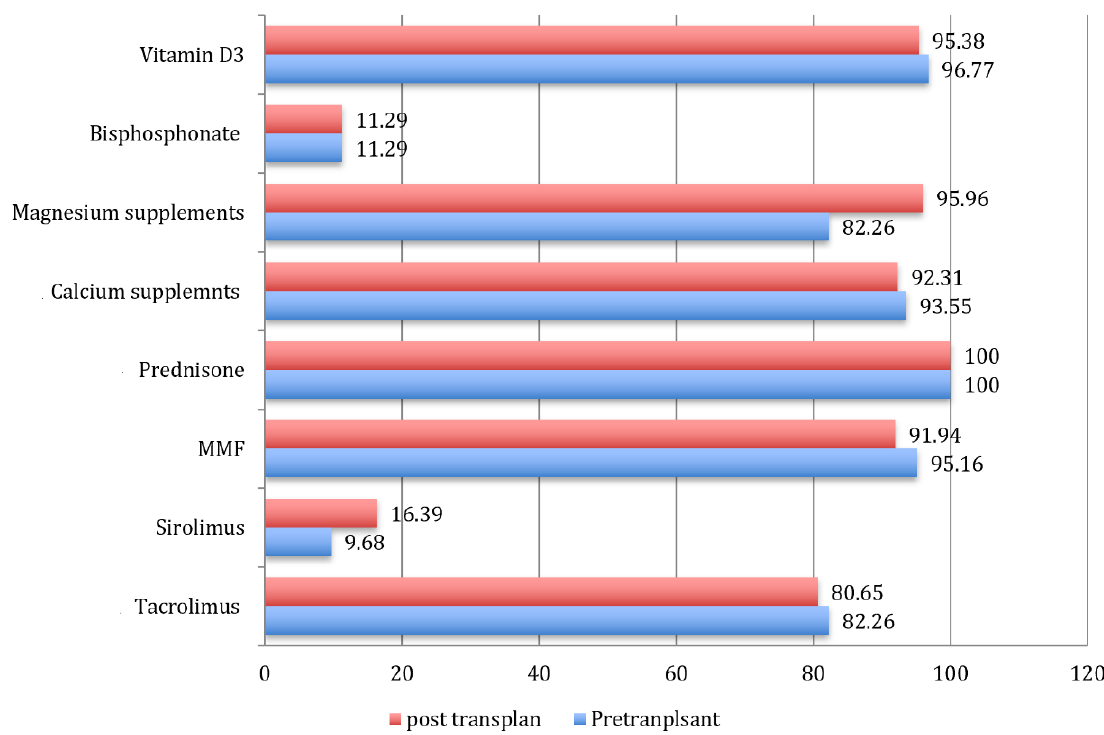
Figure 1. Medications intake by study population in the pre-transplant and post-transplant phases (numbers refer to frequencies of medication use, MMF = mycophenolic acid).